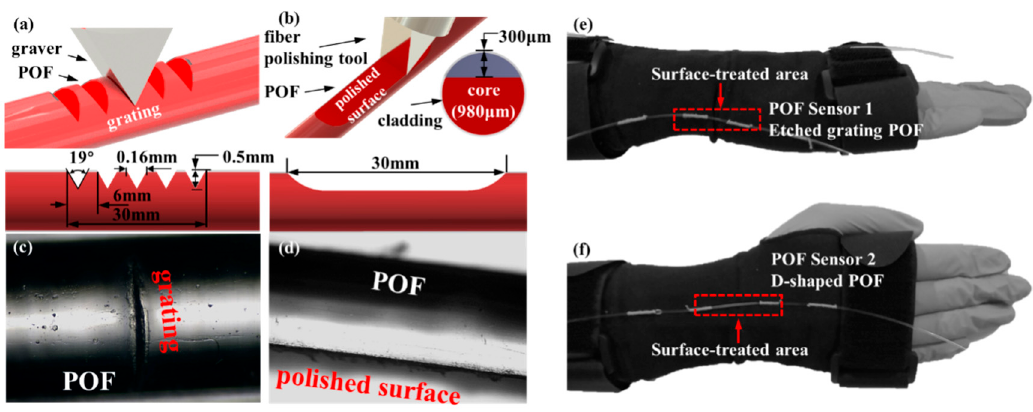
Figure 1. ( a ) Etching periodic grating and ( b ) side-polishing the cladding surface on a plastic optical fiber (POF). Microscope view of ( c ) the etched grating and ( d ) the side-polished fibers. ( e ) Side view and ( f ) front view of a wearable wrist brace with the two surface-treated POFs.